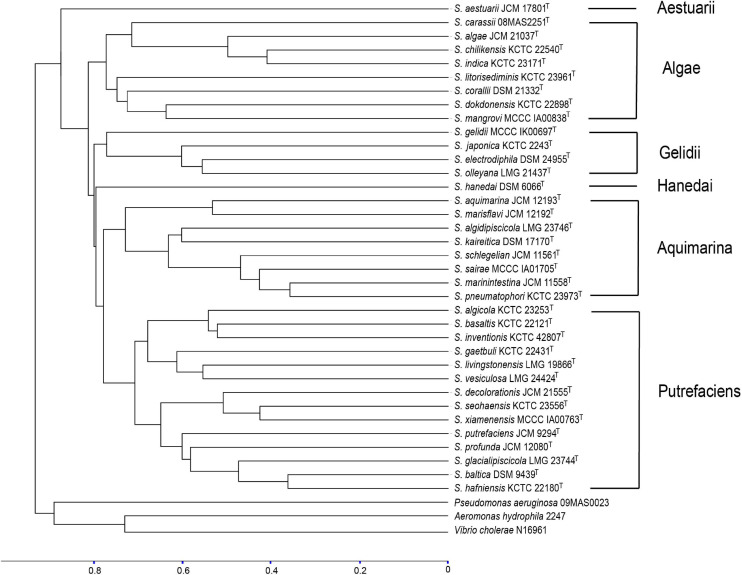
Dendrogram of the cluster analysis of matrix-assisted laser desorption/ionization time-of-flight (MALDI-TOF) mass spectra. The scale below the dendrogram represents the degree of difference in the mass spectrometry fingerprinting of the 36 Shewanella type strains, and the difference level reflects the relationship between each other, with the value between 0 and 1. With the main spectrum projection (MSP) similarity of 77.6% as the critical value, 36 type strains of Shewanella were divided into six groups. Among them, Algae, Gelidii, Aquimarina, and Putrefaciens included multiple type strains (species); S. aestuarii and S. hanedai stood separately in their own clade.